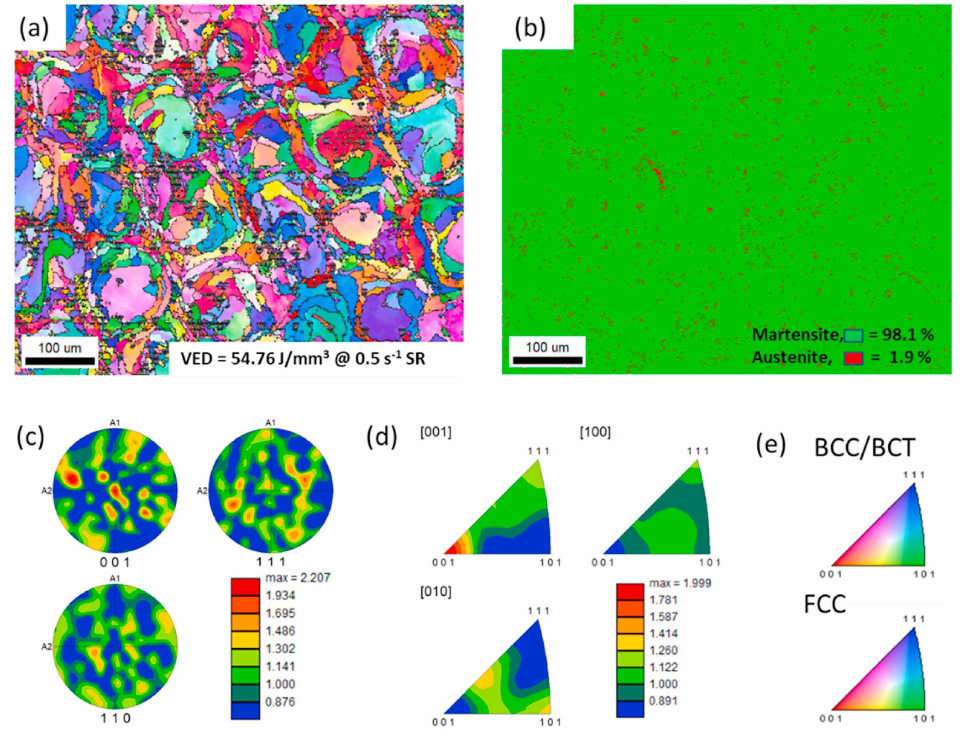
Figure 12. EBSD micrographs of nanoindentation region (at 0.5 s − 1 strain rate) of as-printed L-PBF PH17-4 PHSS part with VED = 54.76 J/mm 3 [159]: ( a ) IPF image in the (X–Y) plane perpendicular to the print direction, ( b ) phase map, ( c ) texture pole figure, ( d ) inverse texture pole figure, and ( e ) IPF color maps of phases. (Reprinted with permission from Ref. [159]. Copyright 2022